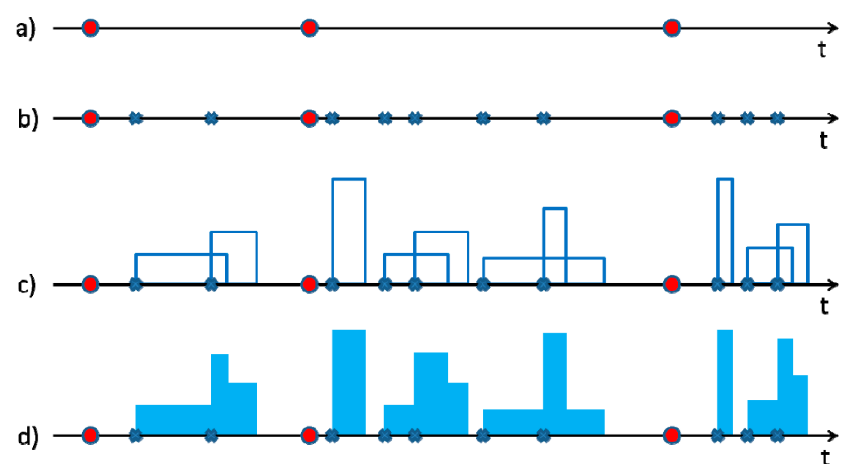
Figure 2. From De Luca and Galasso [27]. Representation of the Neyman–Scott Rectangular Pulses (NSRP) stochastic process for at-site rainfall modeling: ( a ) occurrences of storms (Equation (1)); ( b ) for each storm, determination of the number of pulses (Equation (2)) and their temporal occurrences (Equation (3)); ( c ) estimation of intensity and duration for all the pulses (Equations (4) and (5)); ( d ) calculus of total intensity at time, t , calculated as the sum of the intensities which are related to the active bursts at time, t .